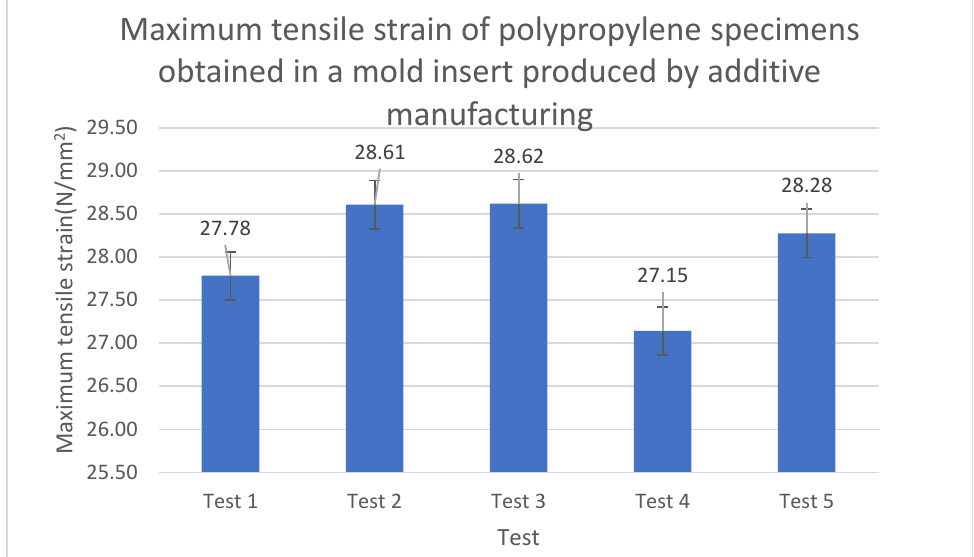
Table 7. Consolidated results of the tensile test on polypropylene specimens obtained in a 3D printed resin mold insert.